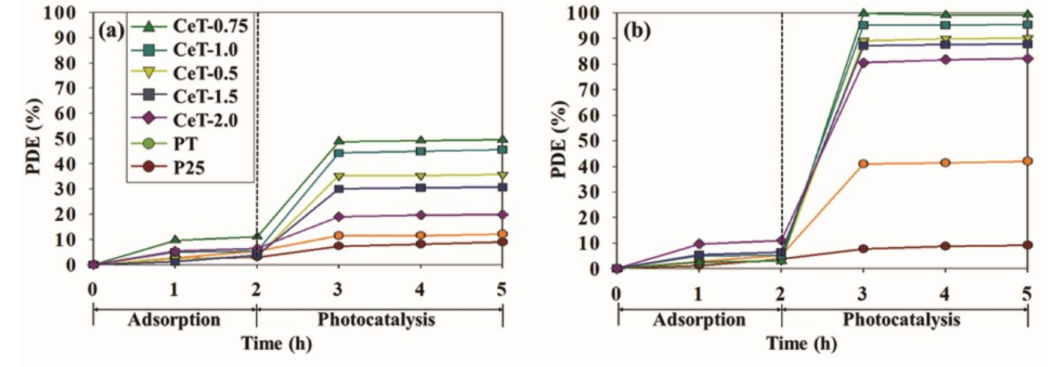
Figure 7. Photocatalytic decomposition e ffi ciencies (PDE, %) for ( a ) toluene and ( b ) o-xylene determined with Degussa P25 TiO 2 (P25), pure TiO 2 (PT), and Ce-doped TiO 2 catalysts with di ff erent Ce contents (CeT-0.5, 0.75, 1.0, 1.5, and